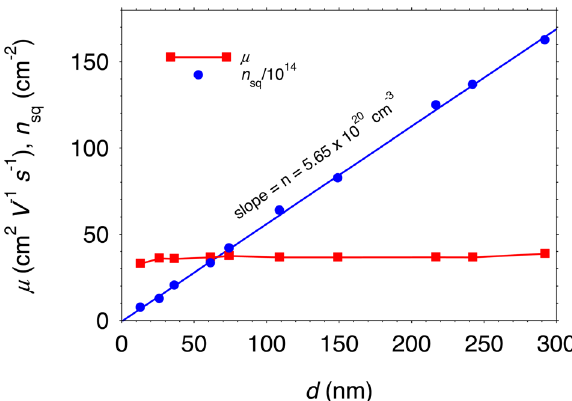
Fig. 2 Sheet carrier concentration and mobility as a function of thickness at room temperature. The slope of sheet carrier concentration n sq (solid blue circles) vs thickness d is the volume carrier concentration n (solid blue line), which is nearly constant at 5.65 × 10 20 cm − 3 . The mobility μ (solid red squares) is about 38 cm 2 V − 1 s − 1 and only a weak function of d